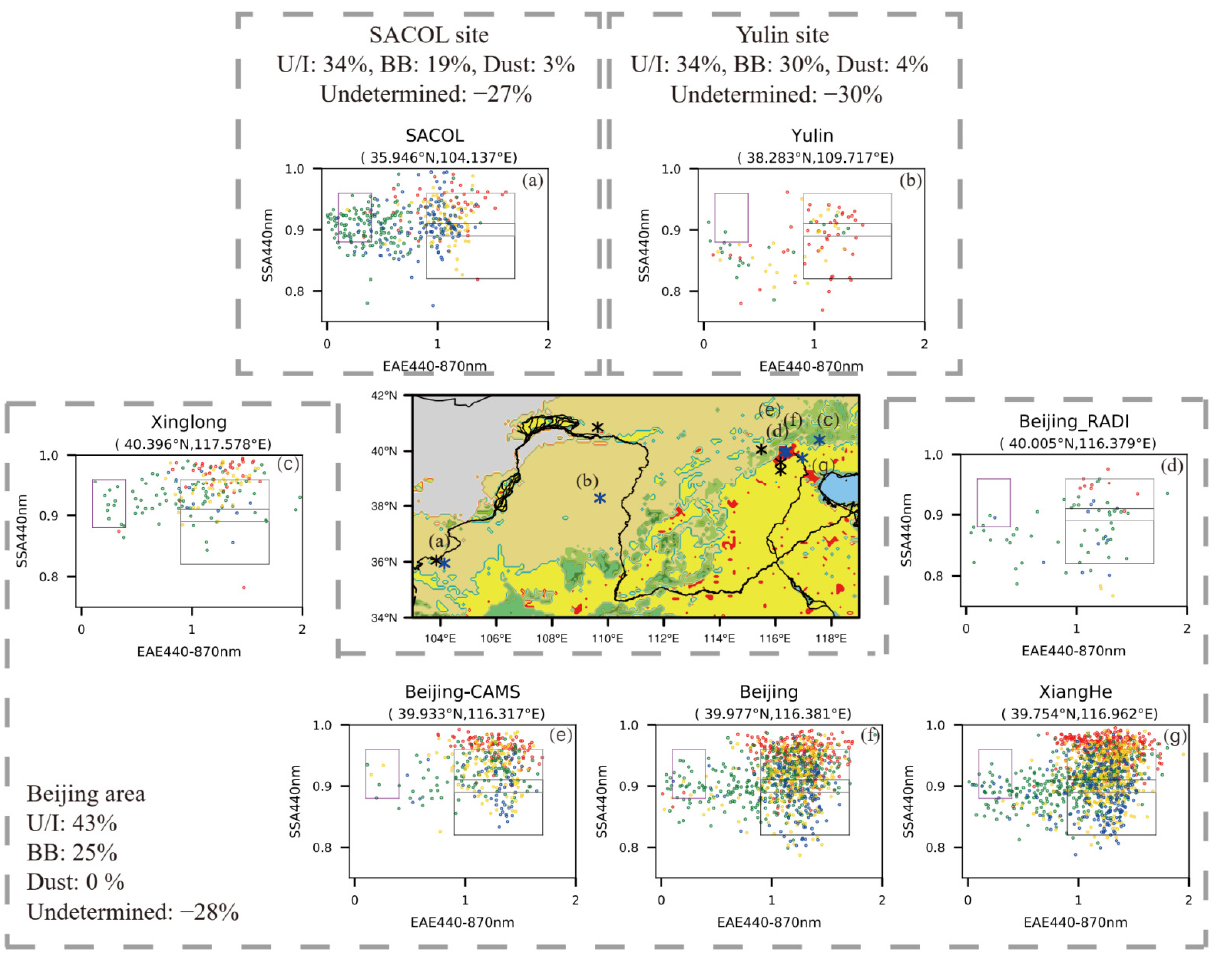
Figure 7. The same as Figure 6 but for the aerosol classification by the 2-D clustering method using SSA and EAE at the AERONET sites ( a – g ) in northern China.